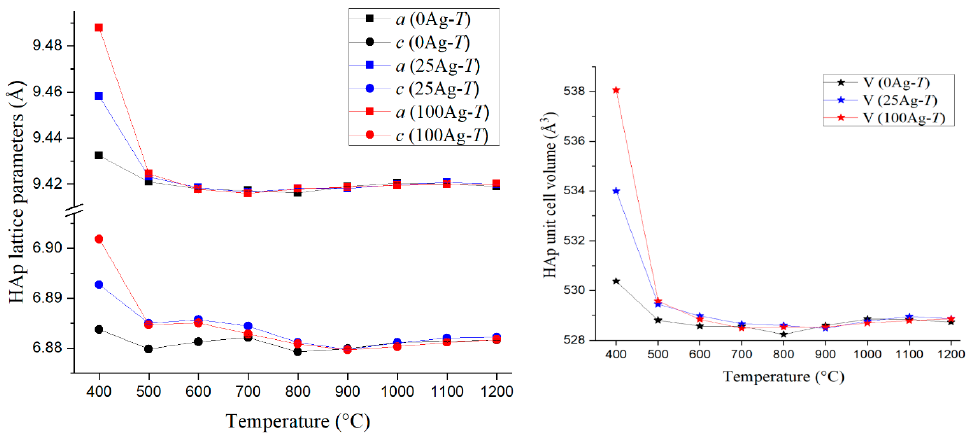
Figure 3. Thermal variation in the HAp lattice parameters for the three series of samples. ( Left ): a (squares) and c (circles) hexagonal lattice parameters; ( right ): unit cell volume (stars). Lines are guides for the eyes only.